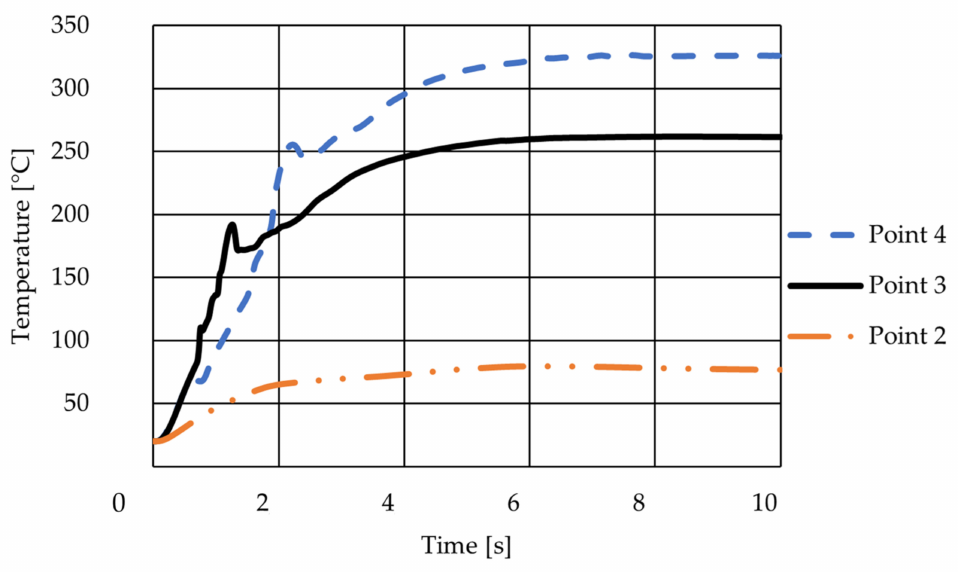
Figure 10. Graph of simulation temperature monitoring at selected points of the new